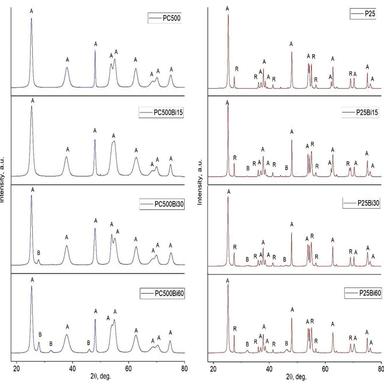
XRD patterns of bismuth oxide-coated and uncoated titanium dioxide samples (A – anatase; R – rutile; B – bismuth oxide).